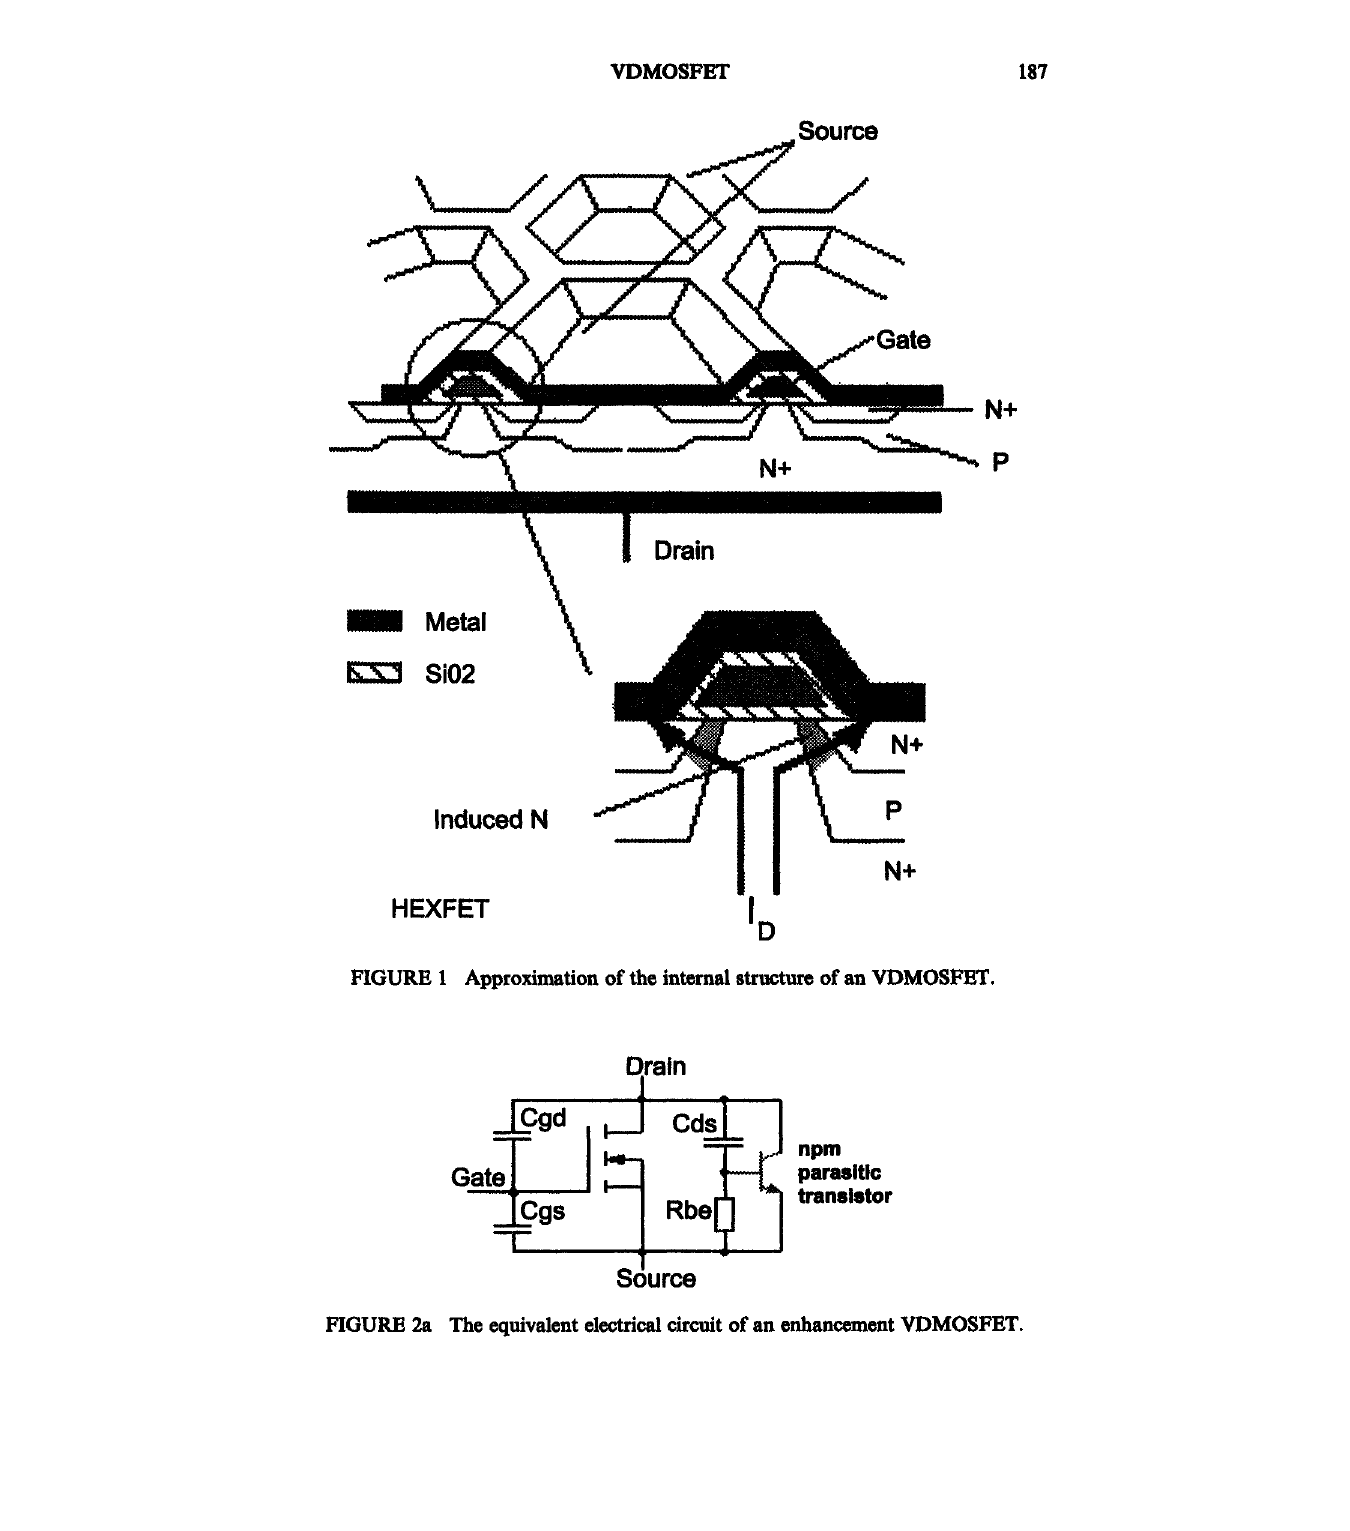
FIGURE 2a The equivalent electrical circuit of an enhancement